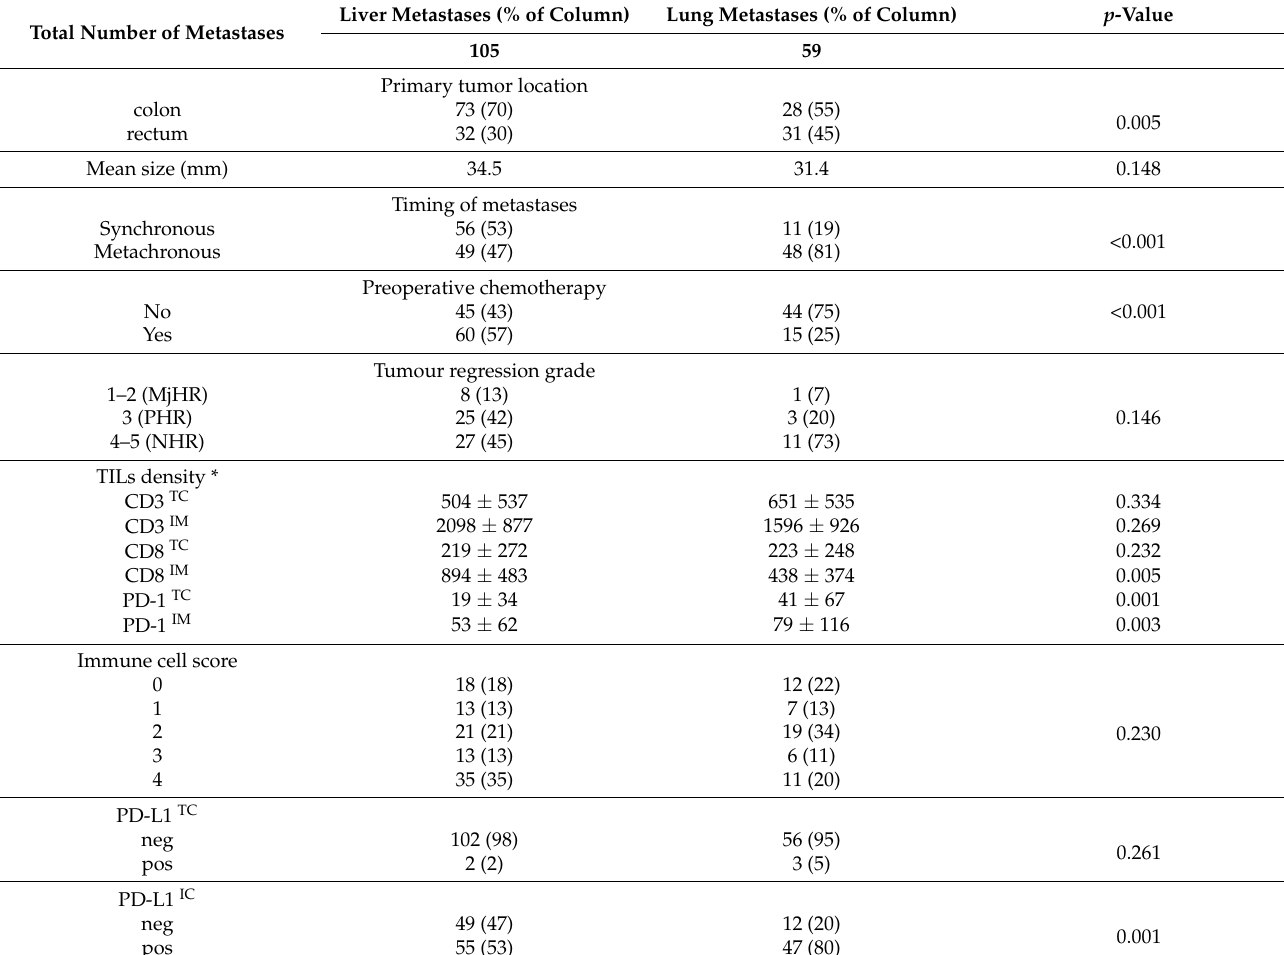
Table 2. Metastases’